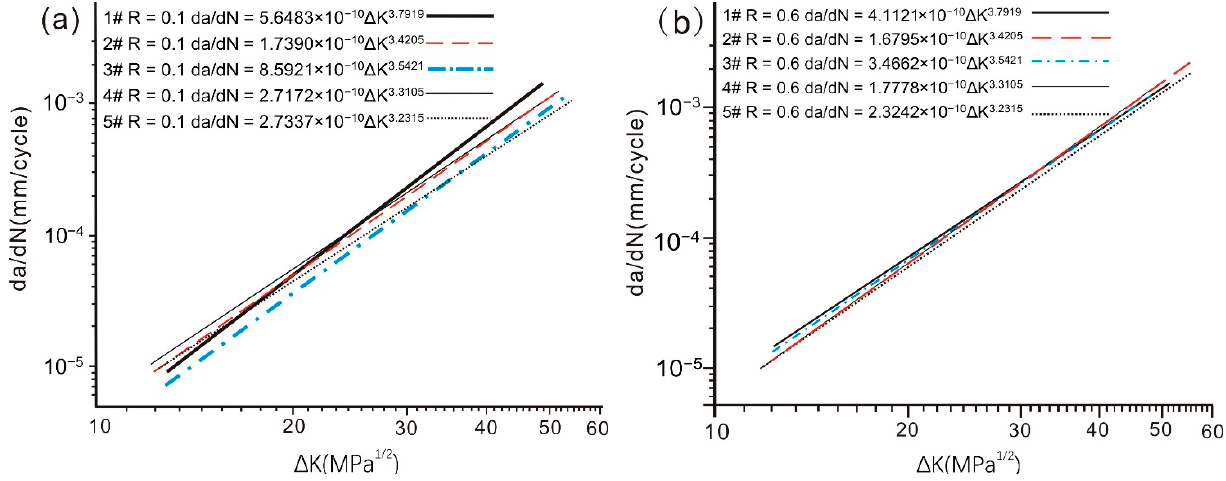
Table 7. Average value of Δ K th of steel-pipe welds (MPa· √ m). Pipe No.